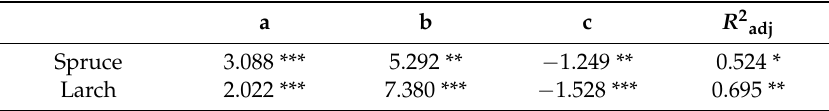
Figure 3. Leaf area per available area (LA/APA in m 2 /m 2 ), leaf area efficiency (LA Eff in m 3 /year and ha), and growth efficiency (Growth Eff in m 3 /year and ha) by species and layer. Cells with n < 15 have been omitted. Table 6. Estimates for the coefficients and statistics of Equation (6).